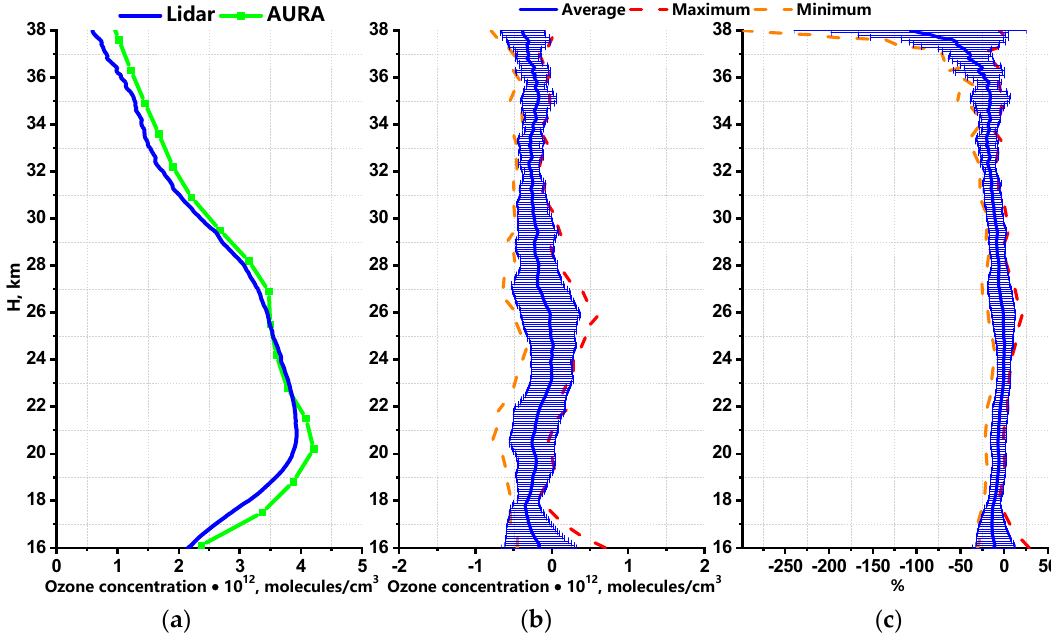
Figure 7. Average OVDs for season of summer–fall and their differences: ( a ) average profiles; ( b ) differences between the lidar and Aura data, in absolute units; and ( c ) relative differences 100 × (lidar − Aura )/lidar.